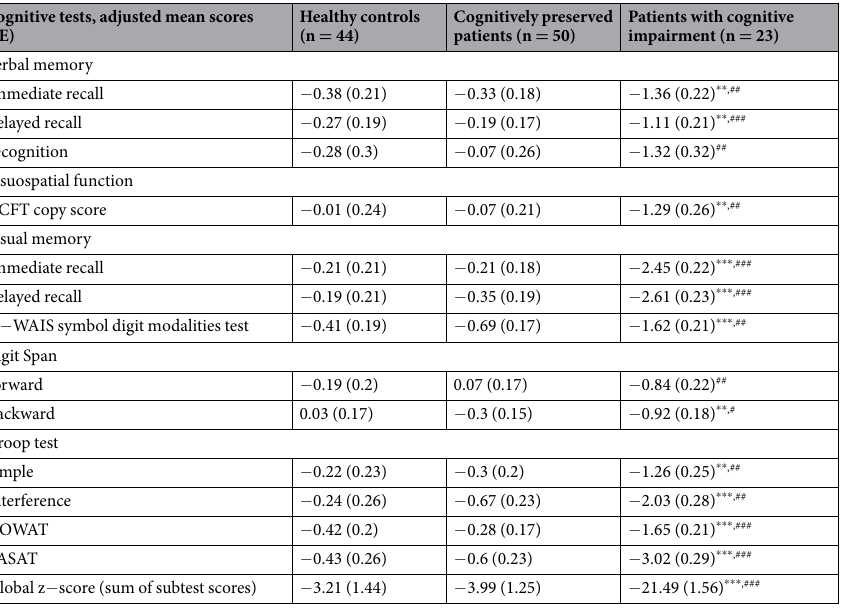
Table 3. Comparison of cognitive scores of healthy controls, cognitively preserved, and impaired patient groups. Abbreviations: BFI = Brief Fatigue Inventory; EDSS = Expanded Disability Status Scale; HCs = healthy controls; NA = not applicable; NMOSD = neuromyelitis optica spectrum disorder; SE = standard error. All comparisons of cognitive function were corrected for age, educational level, and depression level. Post hoc analysis was performed using Bonferroni correction. * p < 0.05 compared to healthy controls. ** p < 0.01 compared to healthy controls. *** p < 0.001 compared to healthy controls. # p < 0.05 compared to cognitively preserved patients. ## p < 0.01 compared to cognitively preserved patients. ### p < 0.001 compared to cognitively preserved